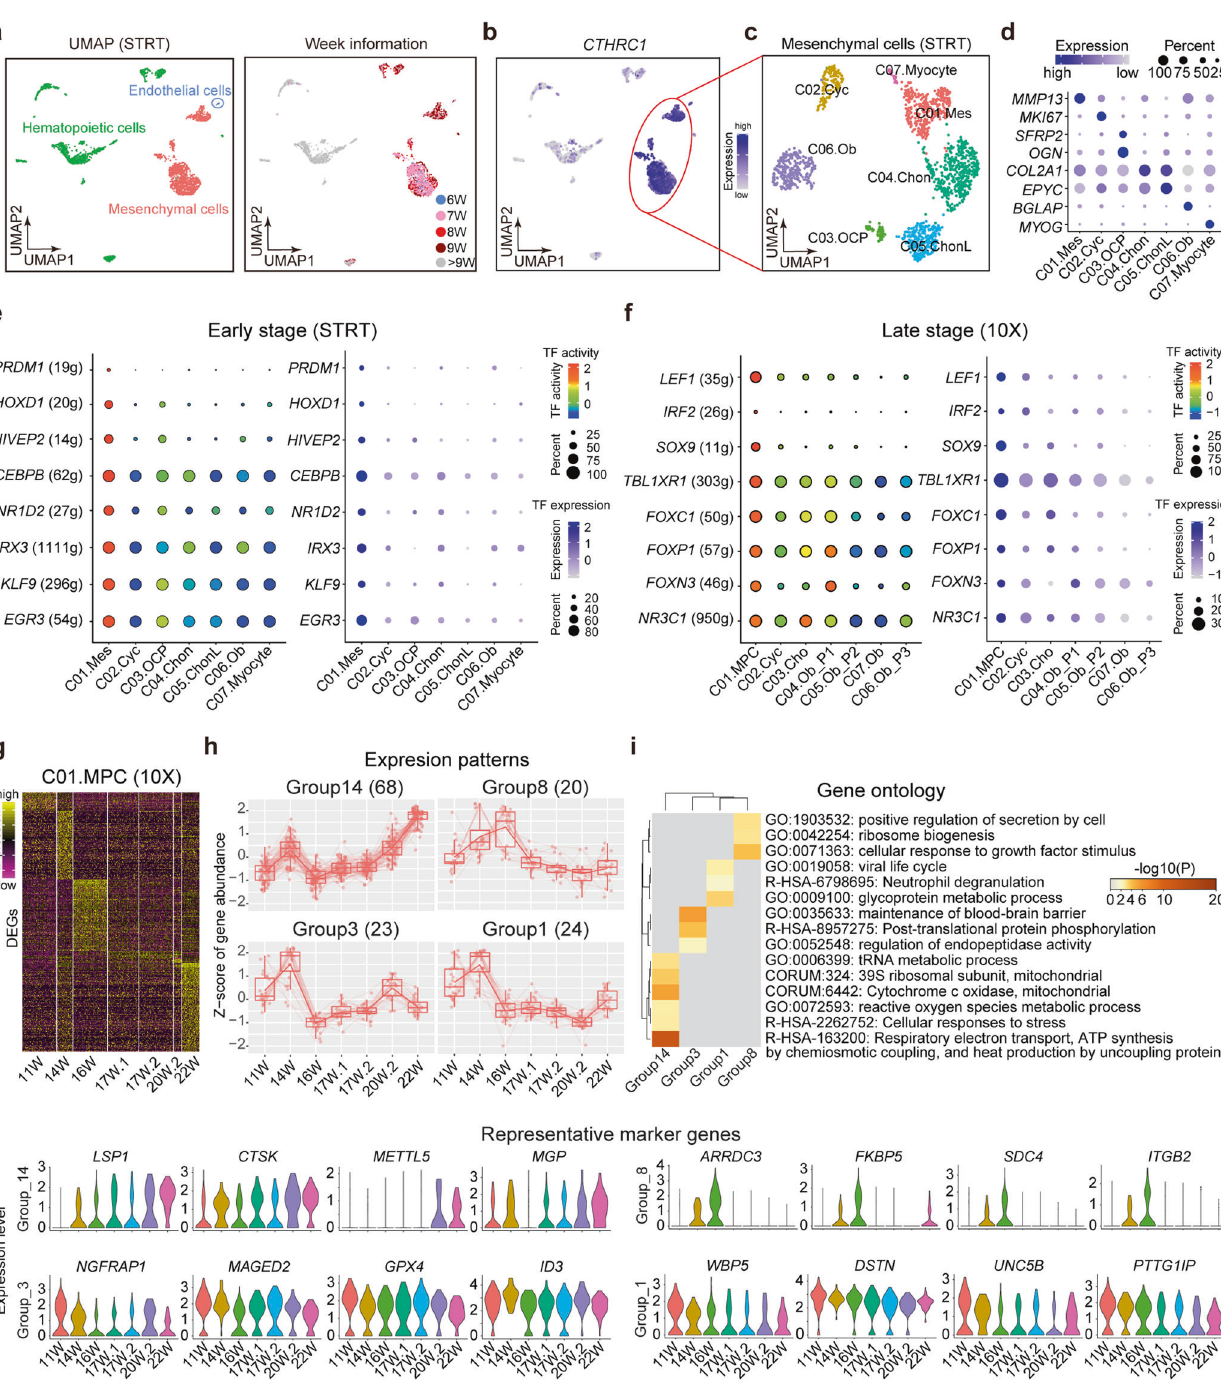
Signal Transduction and Targeted Therapy (2023)